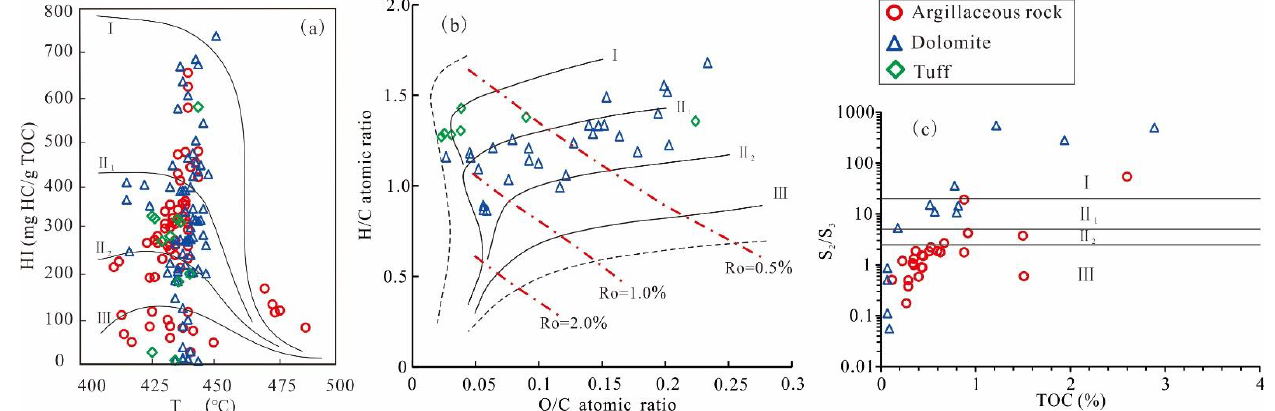
Figure 4. Discrimination diagrams of organic matter types of source rocks in the Fengcheng Formation of the Mahu Sag. ( a ) Plot of T max versus HI. ( b ) Plot of H/C versus O/C atomic ratio. ( c ) Plot of TOC versus S 2 /S 3 .